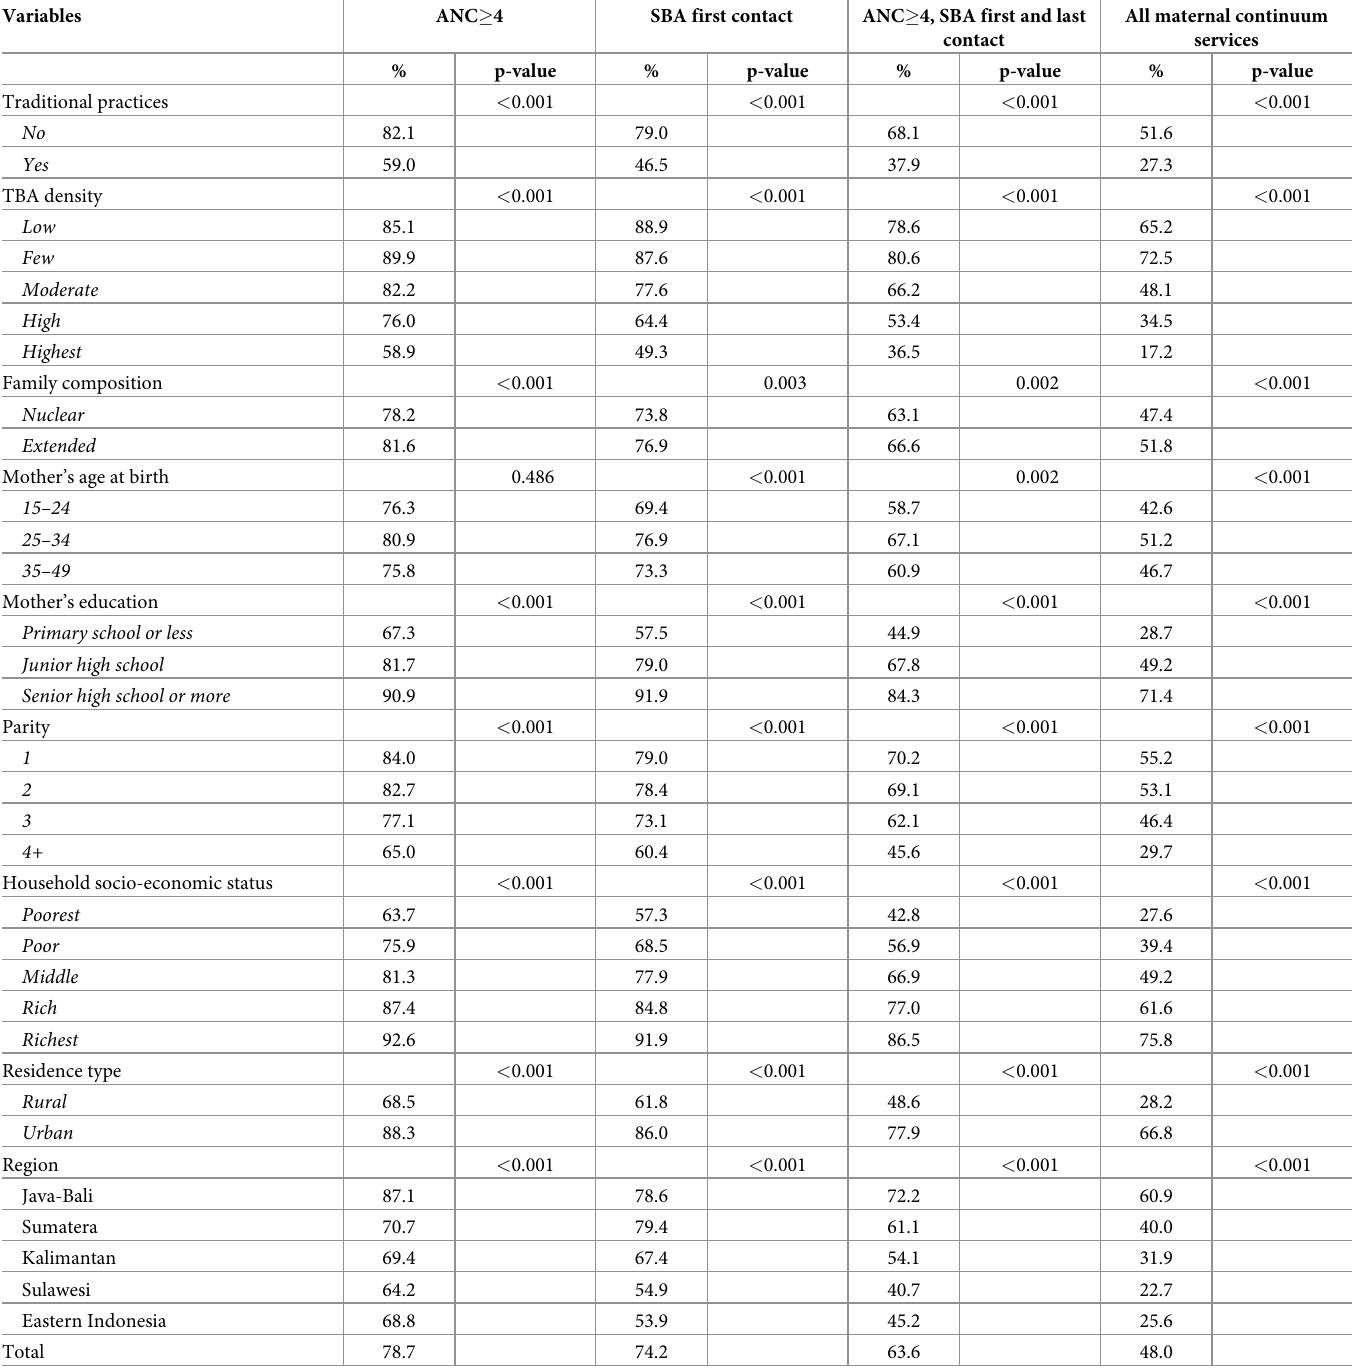
Table 2. Traditional practices and percent of maternal health services